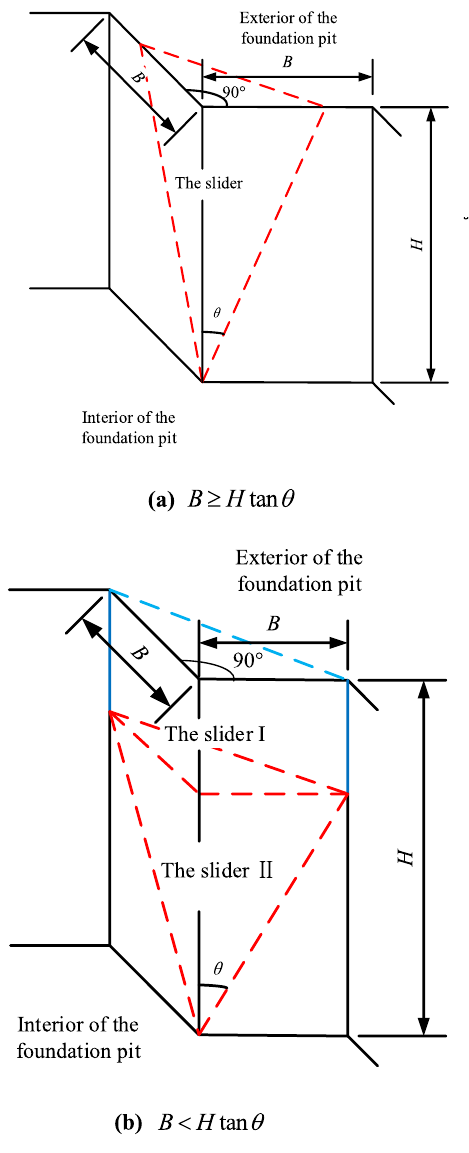
Figure 4. The simplified failure mode of external corners with an angle of